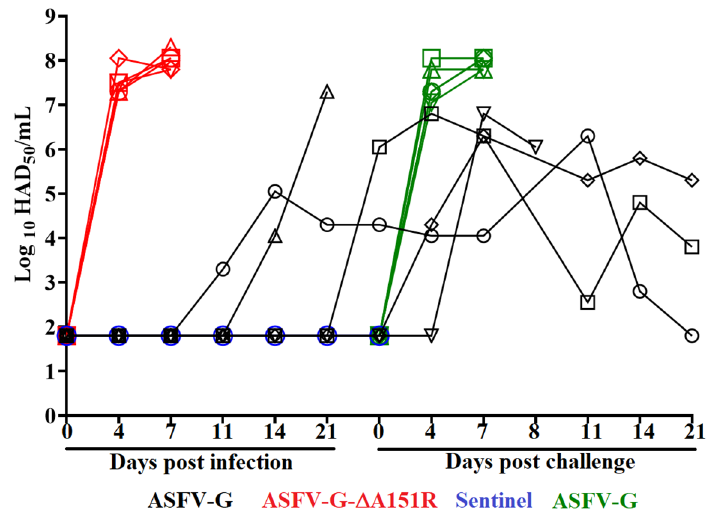
Figure 6. Viremia titers detected in pigs IM inoculated with 10 2 HAD 50 of either ASFV-G- ∆ A151R (black symbols) or ASFV-G (red and green symbols). Each symbol represents the average of animal titers in each of the groups. Sensitivity of virus detection: >log10 1.8 TCID 50 /mL.